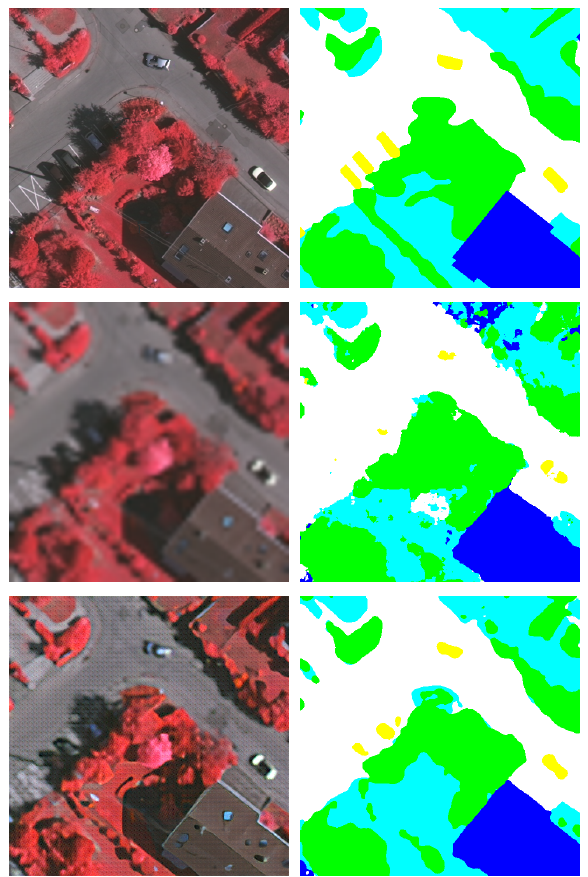
Figure 3. Visual example for the Vaihingen dataset. From up to bottom: (i) HR image and ground truth thematic map, (ii) LR image and its corresponding predicted map, (iii) end-to-end framework reconstructed image and its corresponding predicted